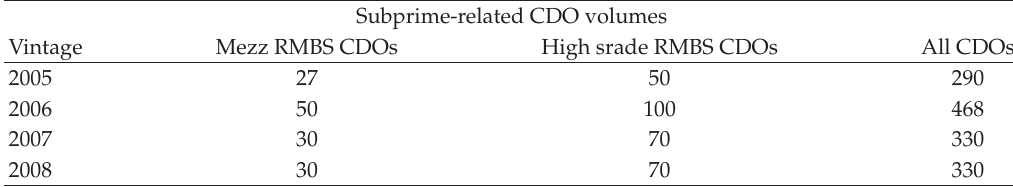
Table 3: Subprime-related CDO volumes; source: (cid:6) 23 (cid:7) . Subprime-related CDO